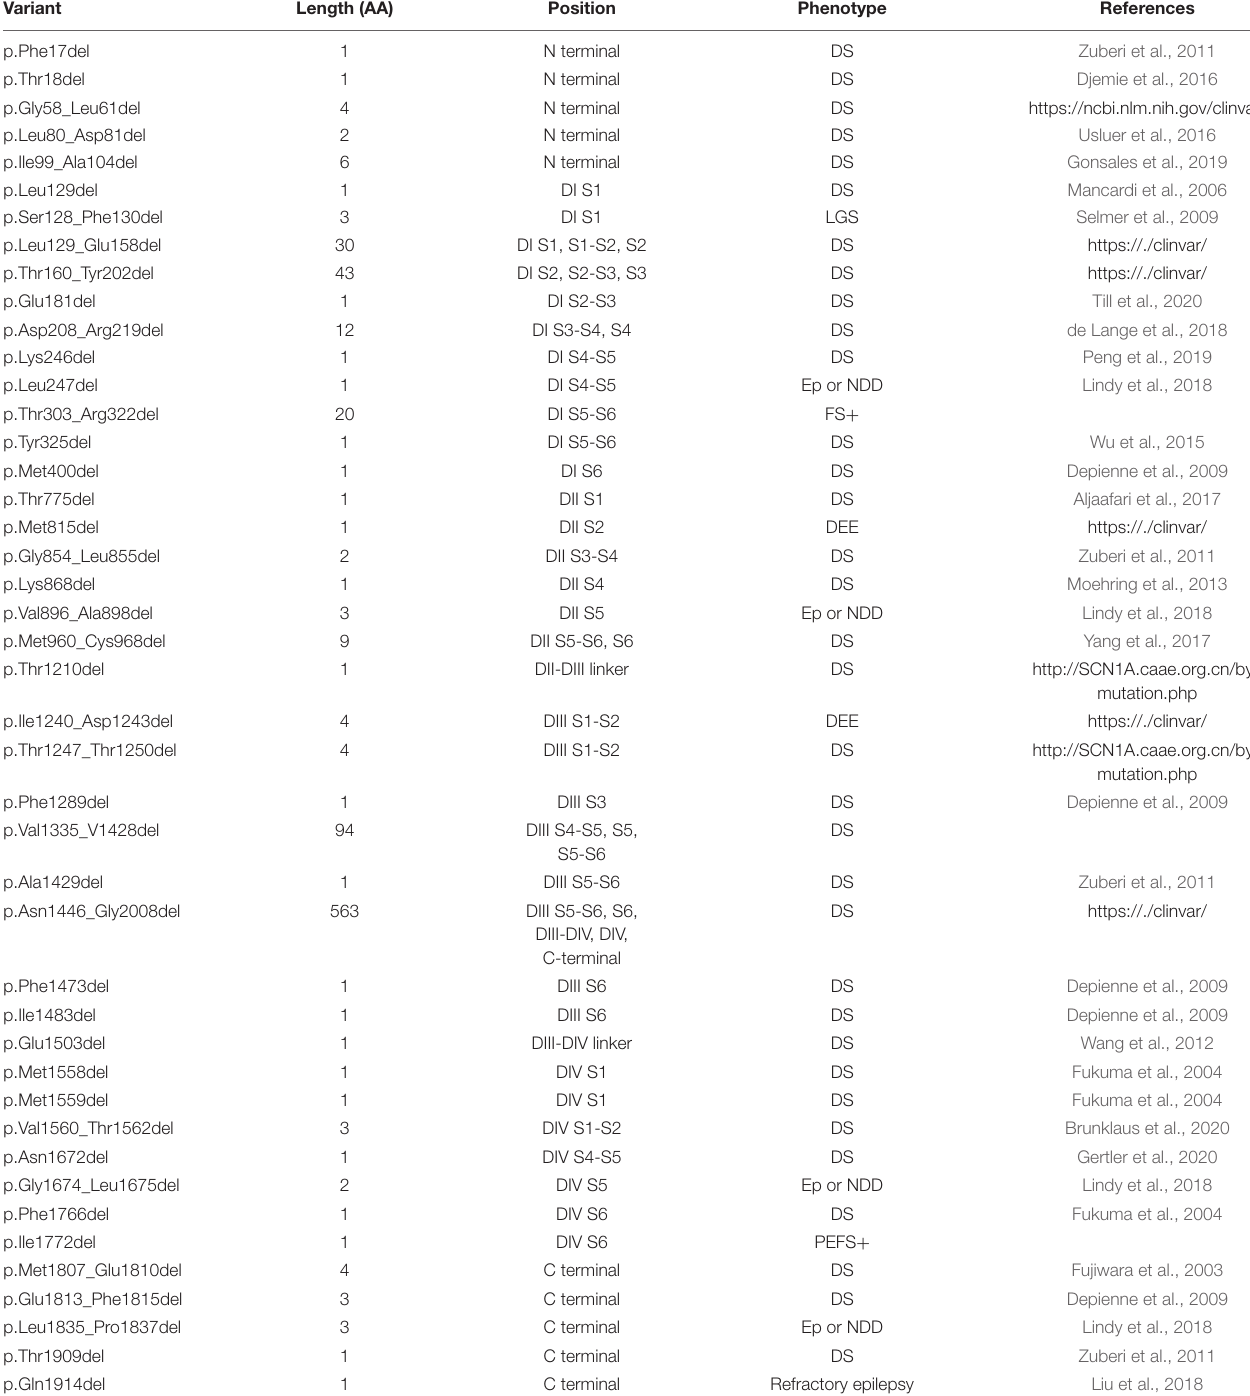
TABLE 2 | In-frame deletion variants of